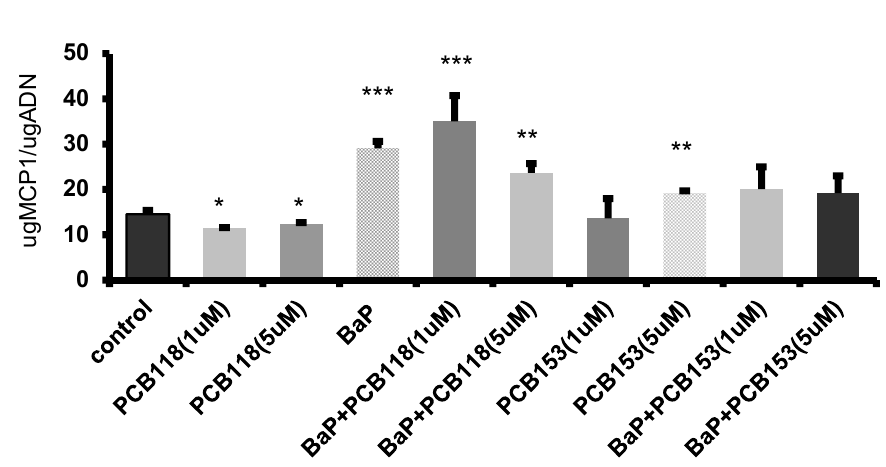
Figure 6. MCP1 immunoassay “Time 1”. 3T3-L1 cells were incubated with or without PCB118 (one or